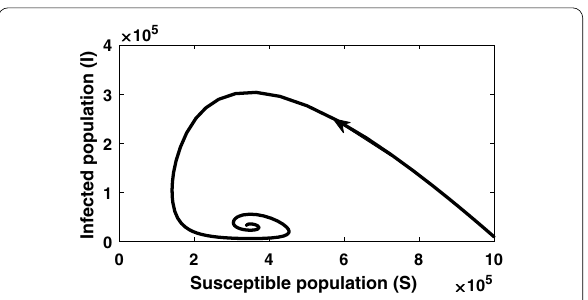
Fig. 7 Phase plane analysis of SIR model with vital dynamics (endemic case). Simulation is done for the initial values S = 10 6 , I = 10 4 , R = 0 and parameter values b = 1 / 60, d = 1 / 60, β = 10 − 6 , γ = 1 /